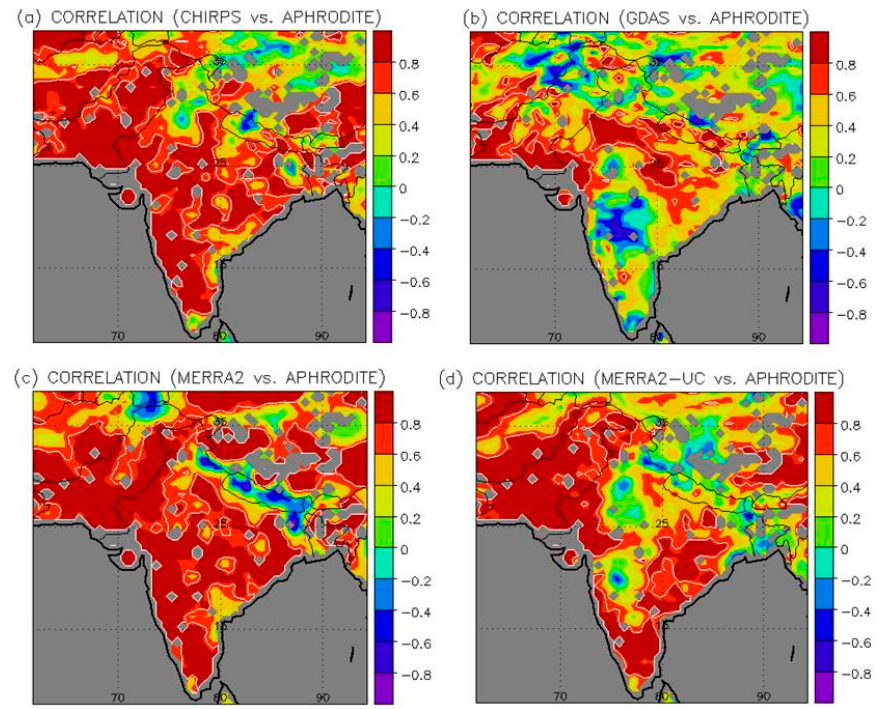
Figure 3. Pearson’s correlation coefficients between annual precipitation from APHRODITE and annual precipitation from ( a ) CHIRPS, ( b ) GDAS, ( c ) MERRA2-C, and ( d ) MERRA2-UC based on the period from 2001 to 2007. The correlation coefficient significant at the 5% confidence level is plotted here with a white line. The grey color indicates the region with no data.